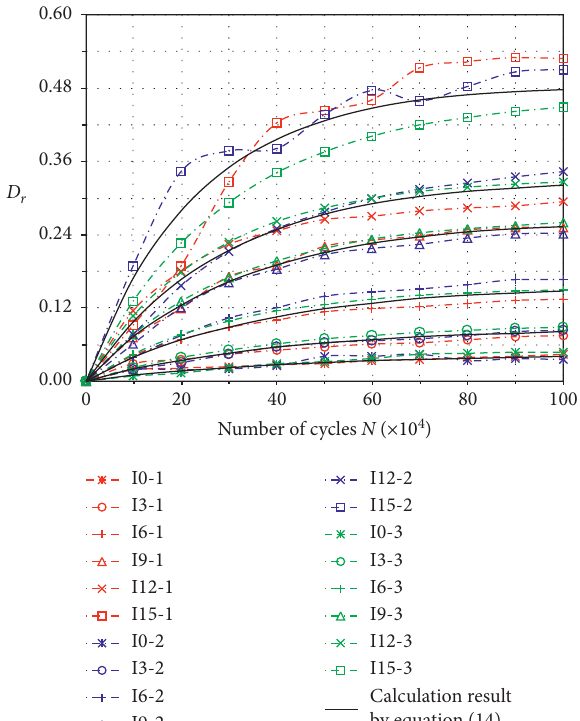
Figure 11: Comparison of calculated results and test data.